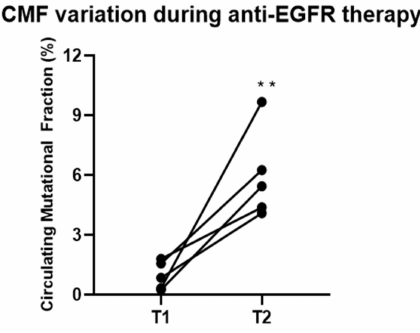
Figure 3. CMF variation during anti-Epidermal Growth Factor Receptor (EGFR) re-challenge treatment ( p = 0.0079). T1: first evidence of KRAS mutant circulating clones, T2: analysis of KRAS circulating mutations 6–8 weeks after T1. **: p <